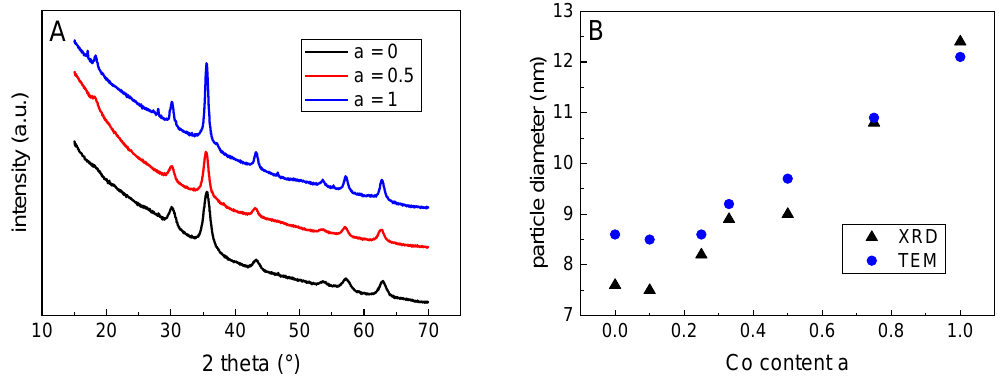
Figure 3. ( A ) X-ray diffractograms of the particles confirm a spinel structure of the particles; for better visibility the curves were shifted manually. ( B ) Particles size derived from XRD and TEM increase upon rising Co content.